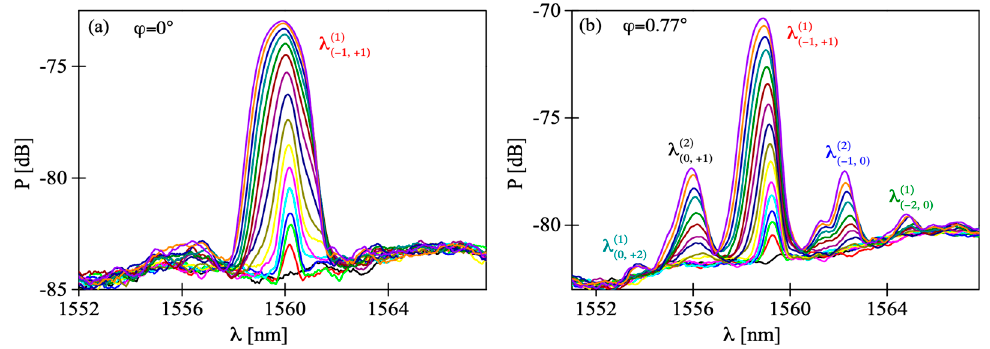
Figure 6. Evolution of the reflection spectra of the fiber Bragg grating (FBG) observed for different tilt angles of the POF.